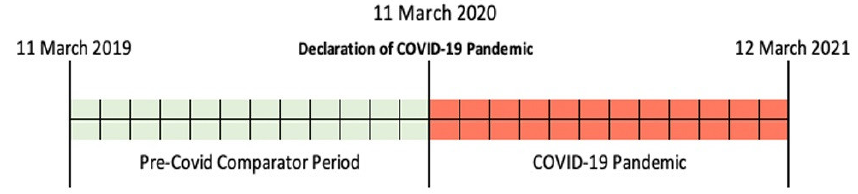
Figure 1. Study Figure 1. Study timeline.